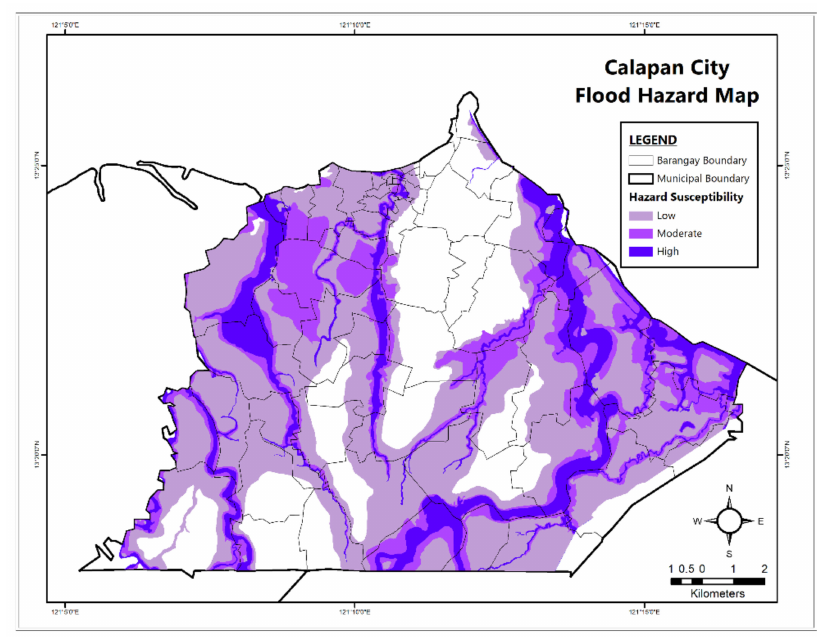
Figure 1. Flood Hazard Map of Calapan City